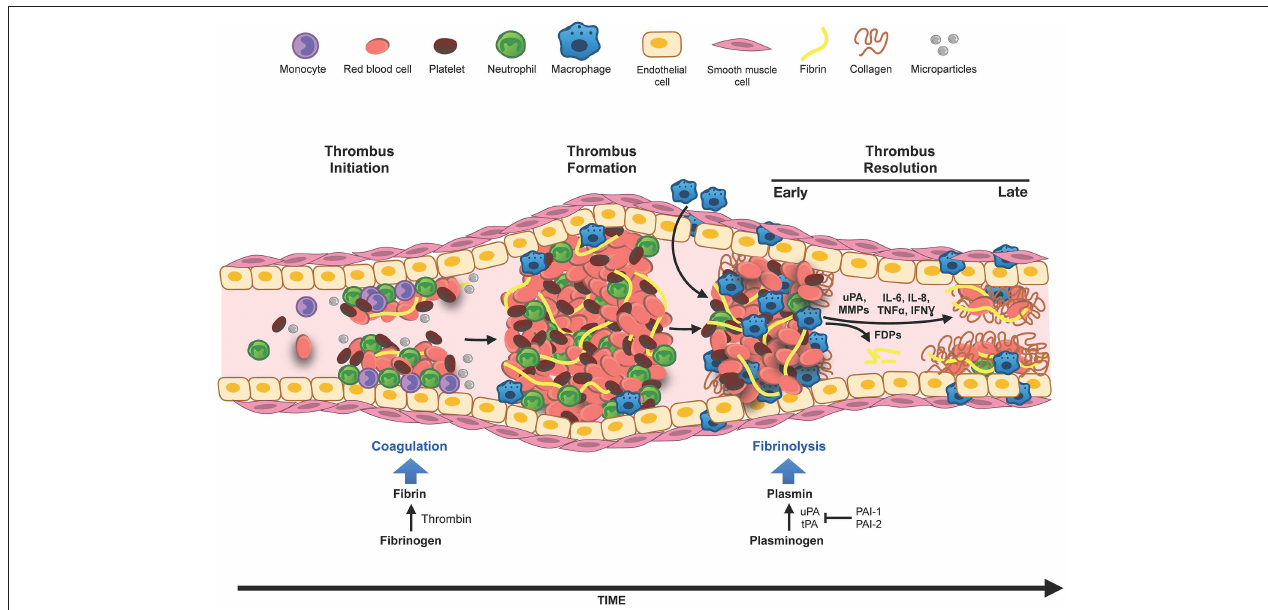
FIGURE 1 | Innate immune cells in DVT. Venous thrombosis can be initiated by venous stasis, increased blood hypercoagulability or endothelial damage. Innate immune cells, neutrophils, and monocytes, bind to the activated vascular endothelium and along with platelets, initiate thrombus formation and fibrin deposition. The thrombus grows by deposition of more fibrin, accumulation of red blood cells and immune cells. Thrombus infiltrating neutrophils and macrophages (differentiated from monocytes) modulate generation of plasmin and matrix metalloproteinases (MMPs), and thus set the stage for fibrinolysis and the collagen remodeling required for the resolution of the thrombus. In the early phase of thrombus resolution, fibrinolysis occurs at a high rate generating fibrin degradation products (FDPs), intrathrombus collagen fibrils start to appear, and thrombus-associated immune cells are induced to produce inflammatory cytokines and various proteases. As the thrombus matures, the rate of fibrinolysis slows down, intrathrombus collagen deposition increases, matrix remodeling via macrophage secreted MMPs occurs and eventually blood flow through the thrombus is restored. Resolution of inflammation and acceleration of this process is believed to be beneficial for restoring vein wall patency and reducing the pathology associated with